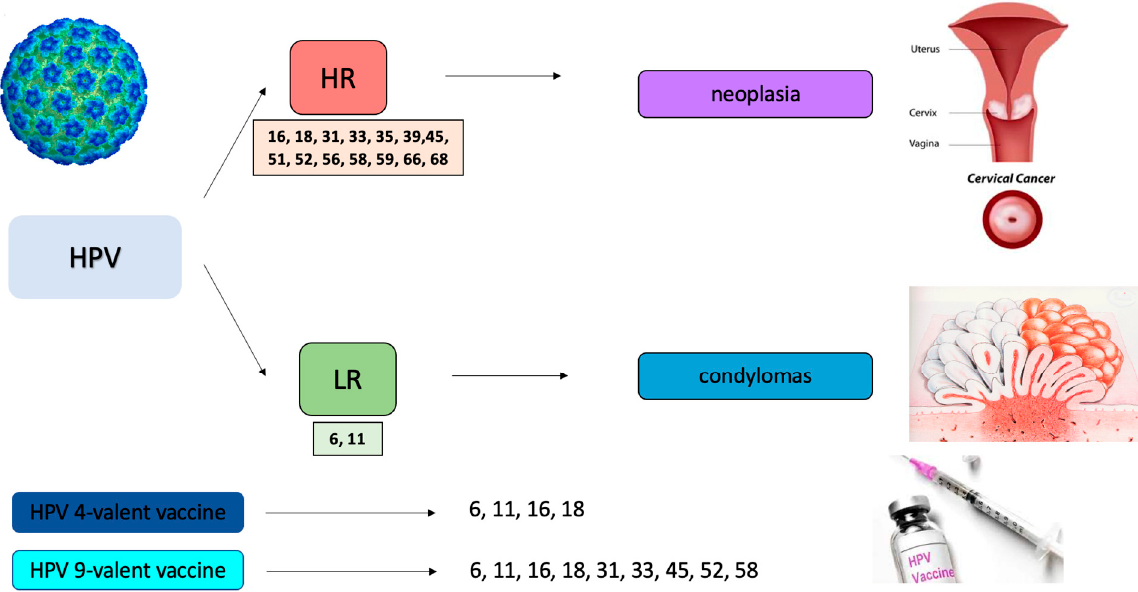
Figure 3. Example image of the etiopathogenesis of HPV to optimize counseling with the patient (HR: high risk; LR: low risk).